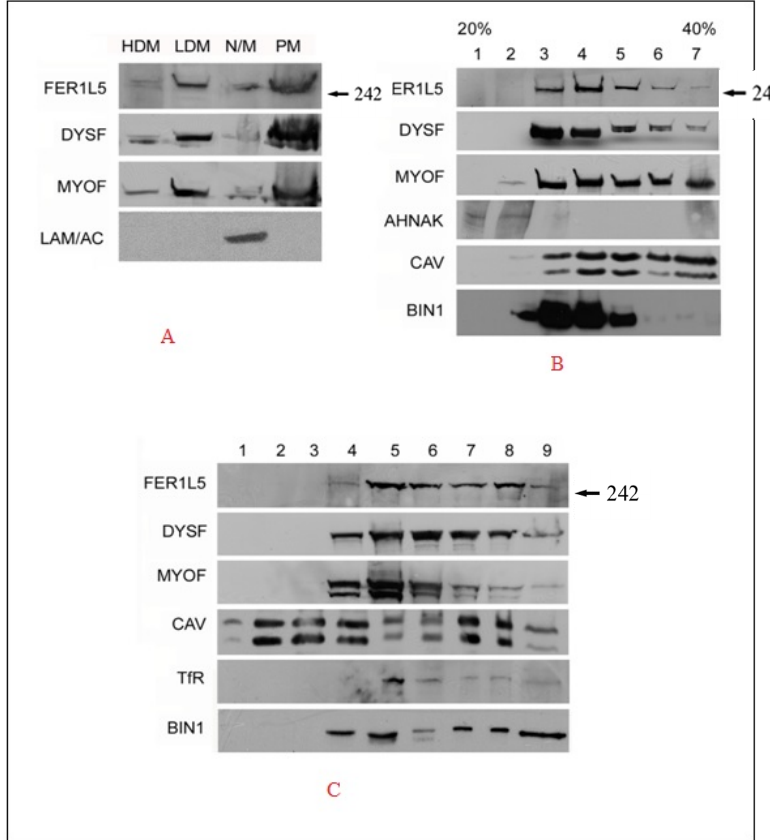
Figure 2. Fer1L5 Subcellular distribution in C2C12 myoblasts. ( A ) Equal volumes of each membrane fraction were analyzed. HDM = high density microsomes, LDM = low density microsomes, N/M = nuclei and mitochondria, PM = plasma membrane. Three independent trials were analyzed in total. LAM / AC is Lamin A. ( B ) A blot shows the post nuclear supernatants of homogenized C2C12 myoblasts loaded onto sucrose gradients ranging from 20–40%. Equal volumes from 7 fractions were collected for analysis. ( C ) Floated fractions 1–4; dissolved fractions 5 to 8. Fraction-9, pellet. The data presented here are representative of two independent